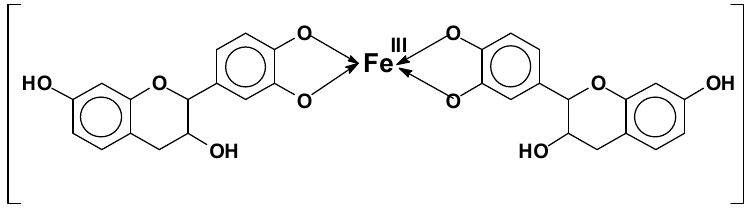
Figure 4. Ferric tannates [31].